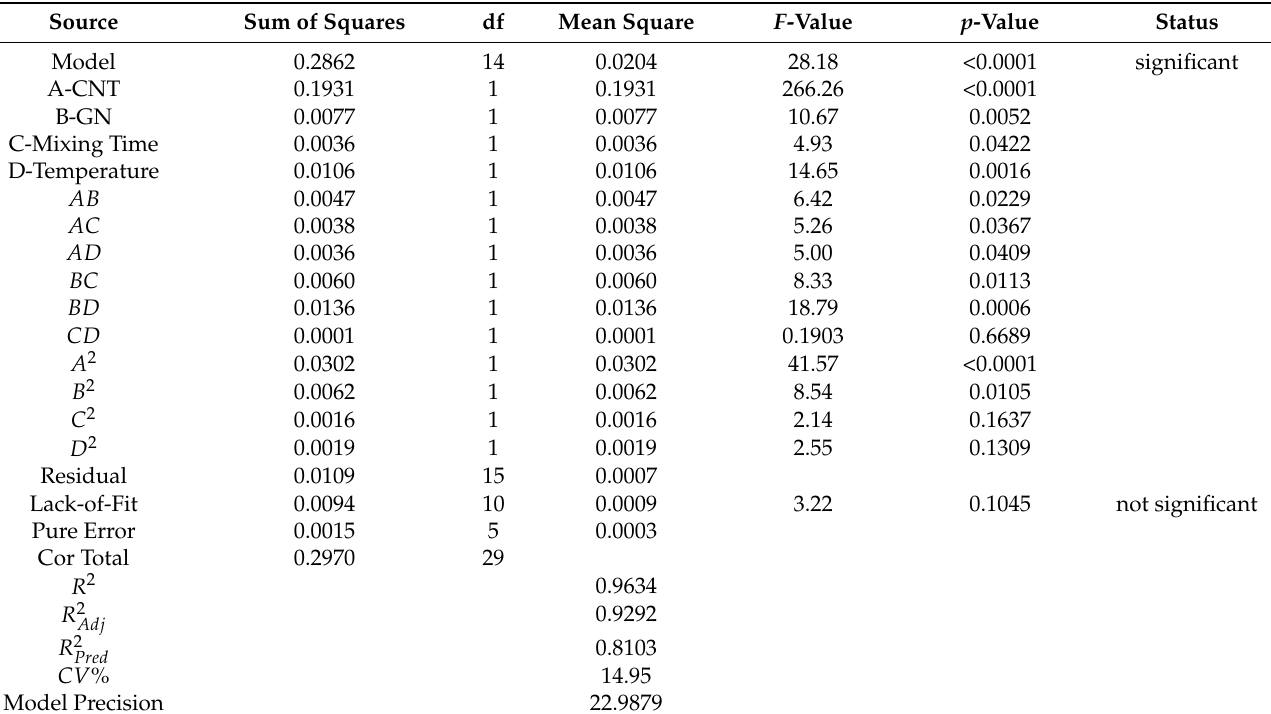
Table 3. Analyses of variance (ANOVA) for response surface model for the sensitivity of CNT/GN- RTV composites using